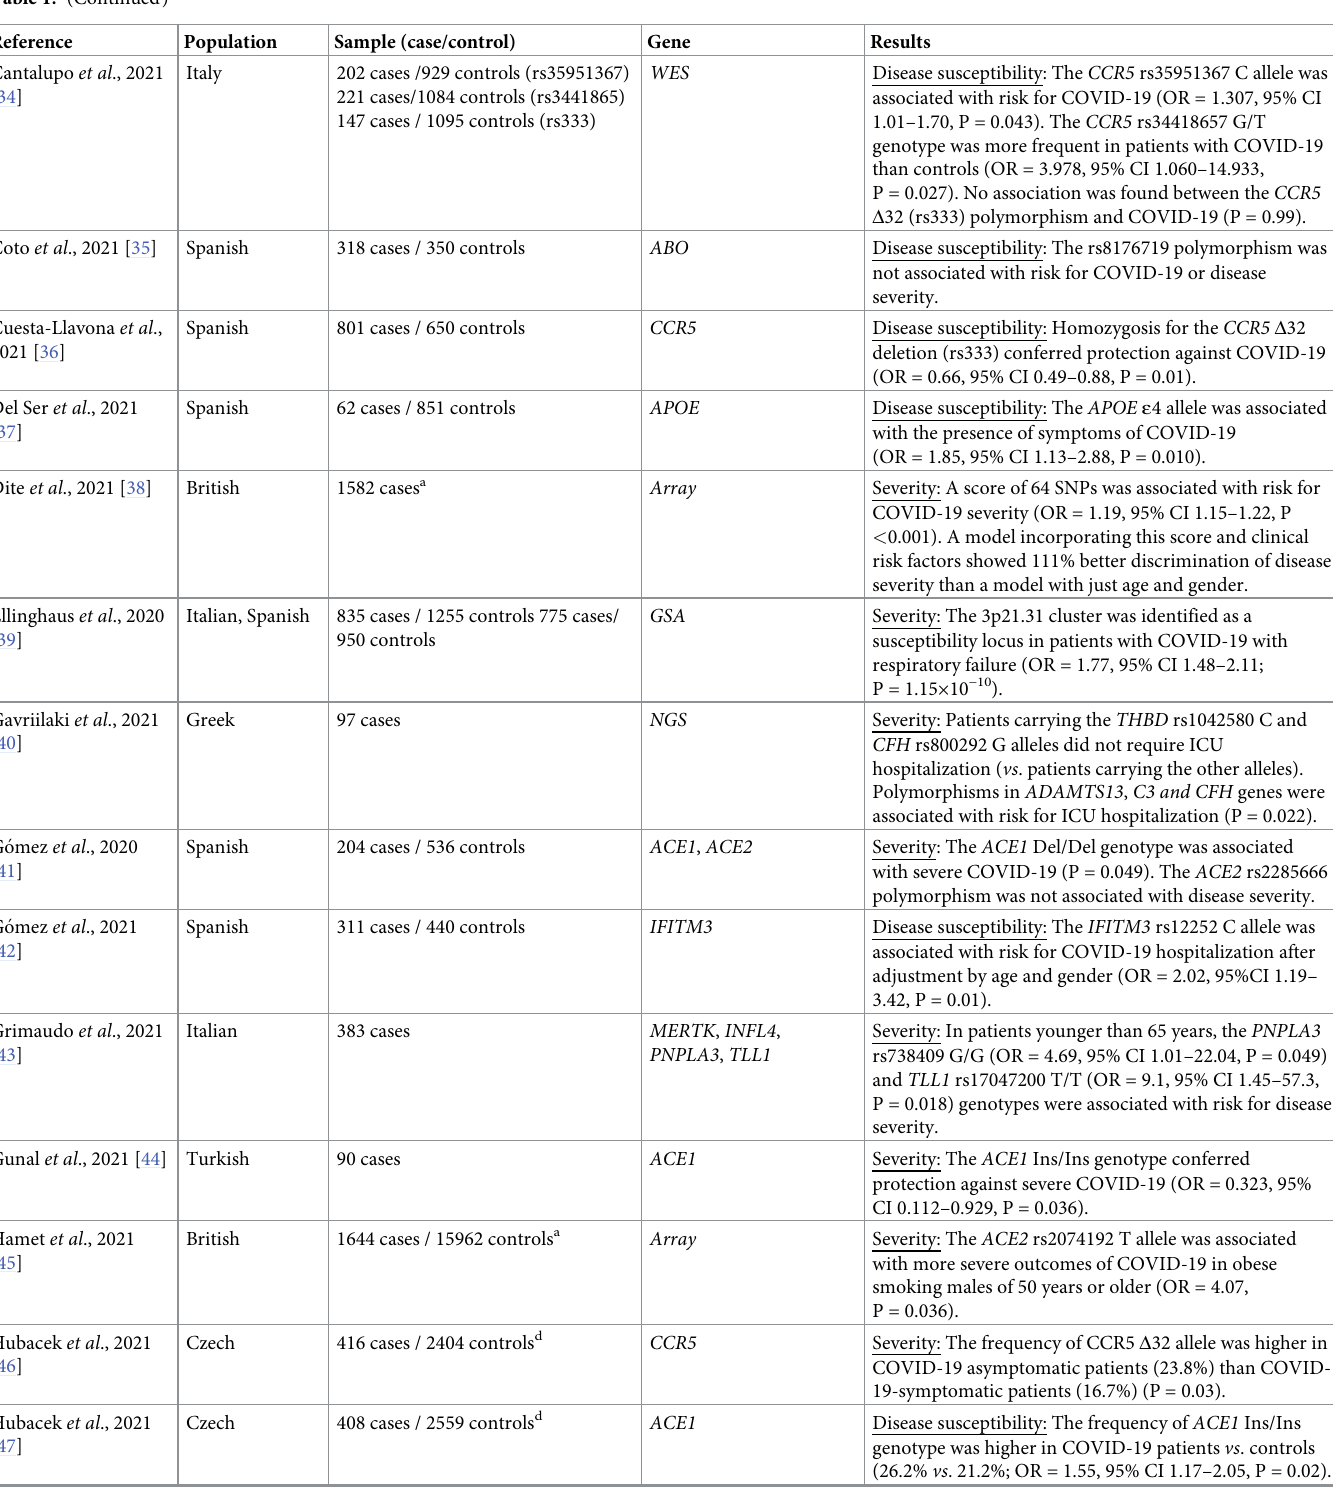
Severity: The ACE2 rs2074192 T allele was associated with more severe outcomes of COVID-19 in obese smoking males of 50 years or older (OR = 4.07, P = 0.036). Severity: The frequency of CCR5 Δ 32 allele was higher in COVID-19 asymptomatic patients (23.8%) than COVID- 19-symptomatic patients (16.7%) (P = 0.03). Disease susceptibility: The frequency of ACE1 Ins/Ins genotype was higher in COVID-19 patients vs .